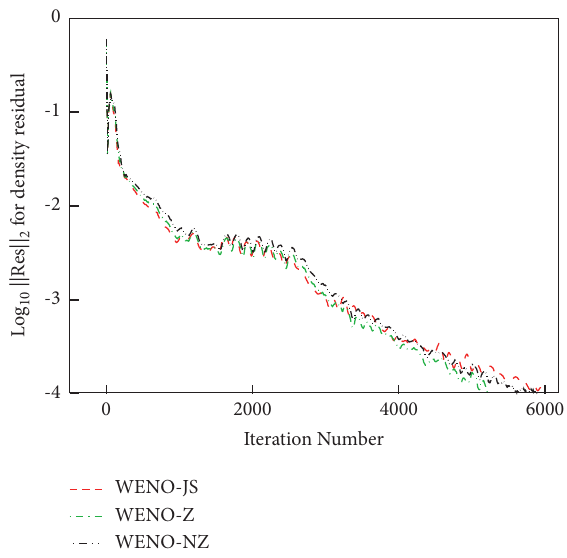
Figure 11: Convergence history for ONERA-M6 wing.